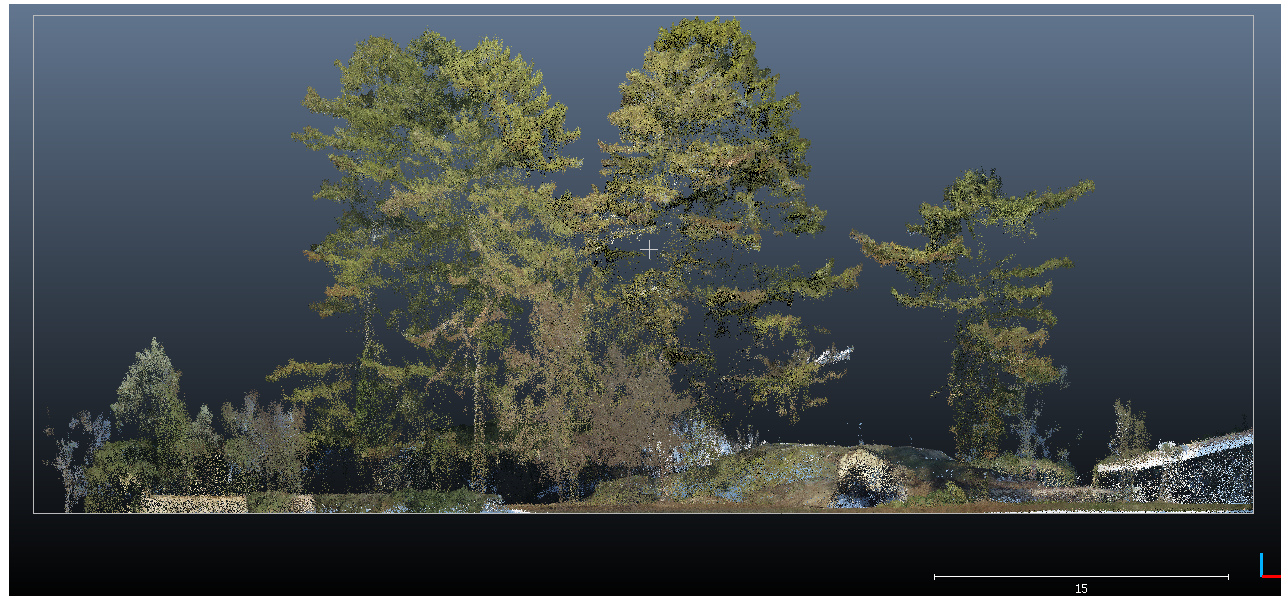
Figure 32. Vegetation of the castle captured by the LiDAR sensor of the Zenmuse